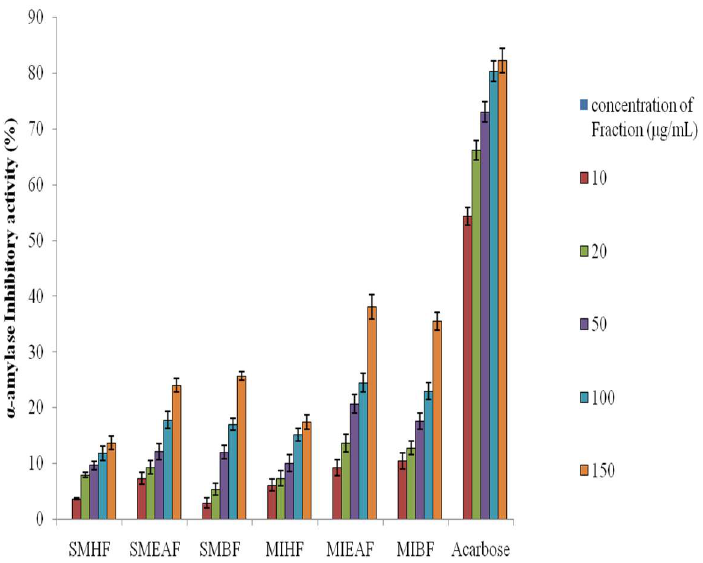
Figure 1. Alpha-amylase inhibitory activity of fractions of S. mombin and M. indica leaves. Legends: